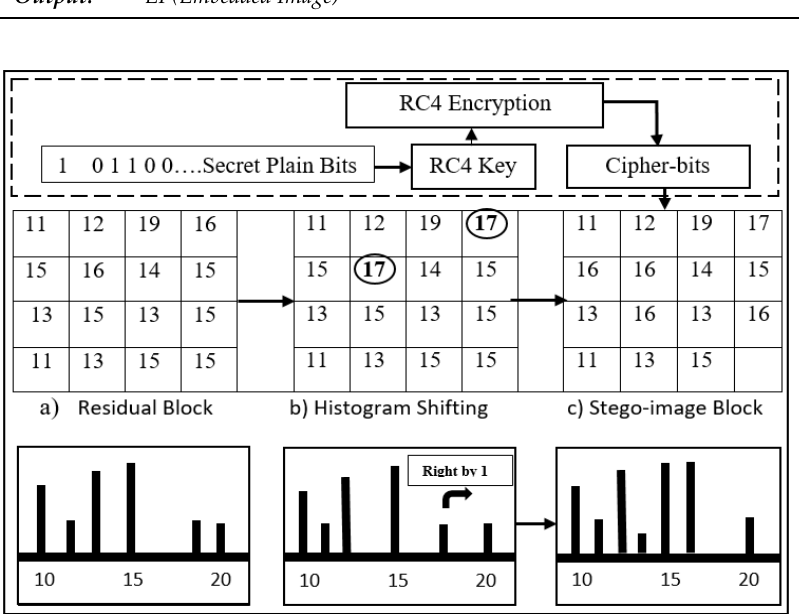
Figure 6. Flowchart of the Extraction Procedure . Step-1: Inverse-S scan the stego-image The stego- image I’ is scanned in inverse S -order. This will ensure the extraction of the secret data bit from the stego-image without losing any data bits.